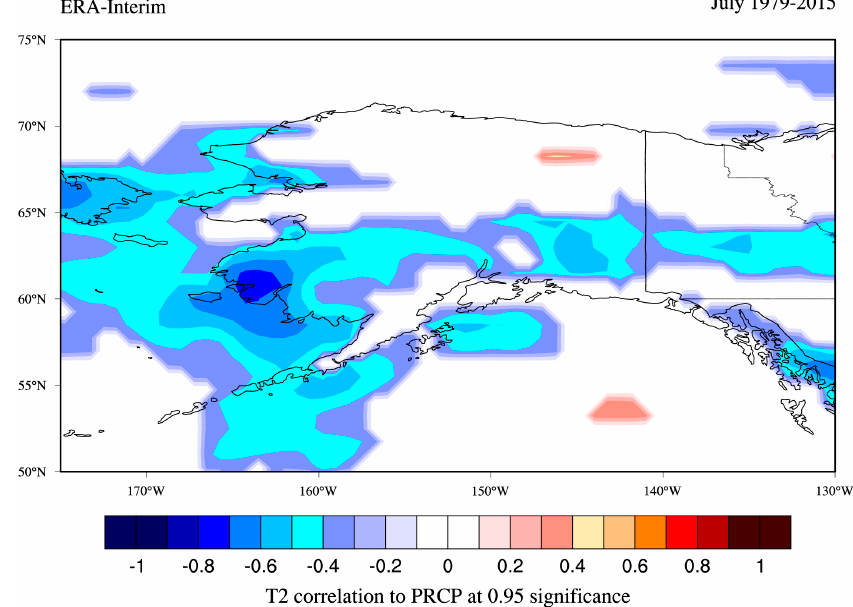
Figure 5. Correlation between precipitation and the 2-meter mean temperature (°C) for the Alaska region for the month of July as derived from the ERA-Interim reanalysis, 1979–2015 [21].